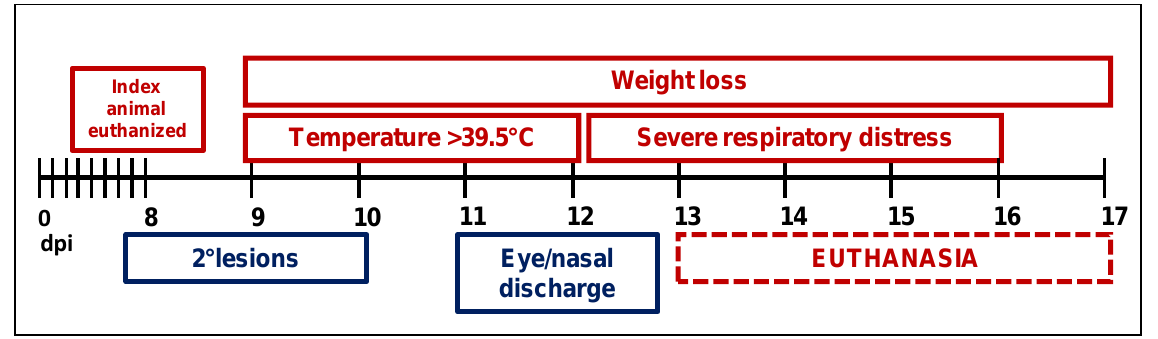
Figure 5. Time line of disease in 8–10 week old New Zealand White rabbits infected via natural aerosol. Symptoms in red boxes represent clinical measurements that contribute to euthanasia guidelines. Clinical symptoms are indicated in blue boxes. Reproduced with permission from American Society for Microbiology